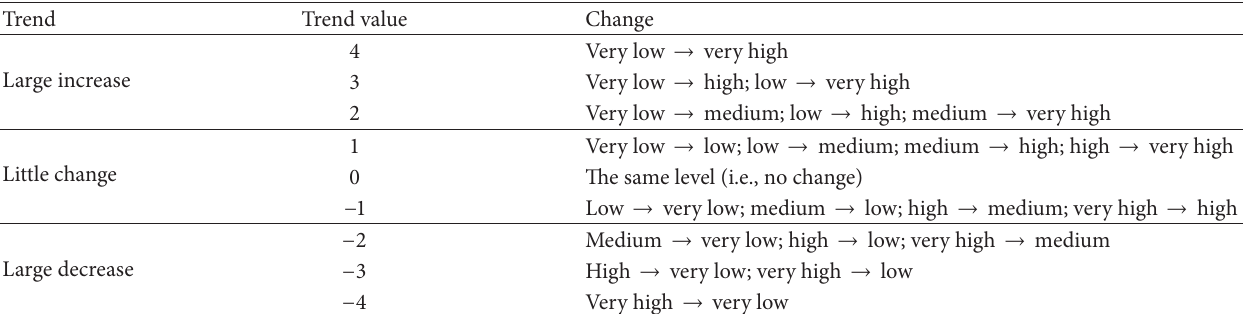
Table 2: The LST changes and their relationships with the three LST trends of large increase, little change, and large decrease. LST